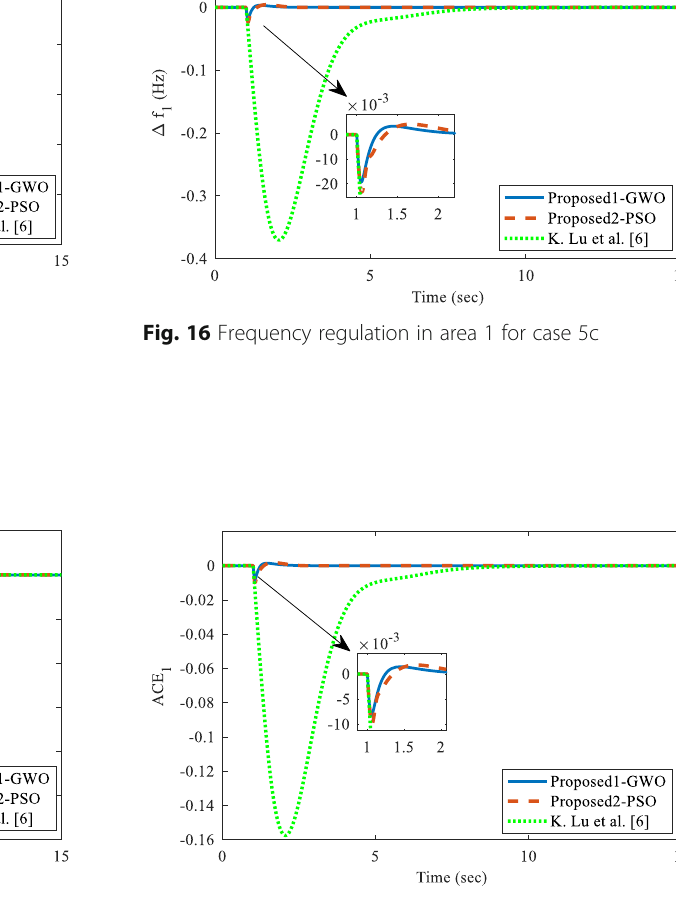
Fig. 17 Area control error in area 1 for case